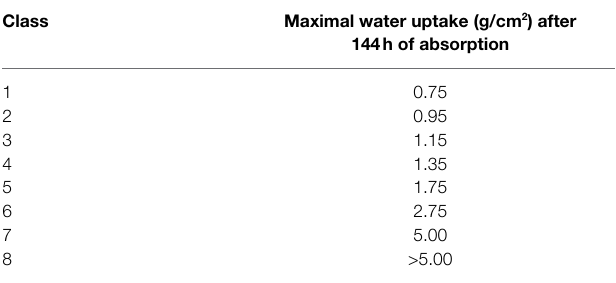
TABLE 3 | Classification of absorption based on water uptake and release (g/cm 2 ) after 144 h, adapted from Van Acker et al. (2014). Class Maximal water uptake (g/cm 2 ) after 144 h of